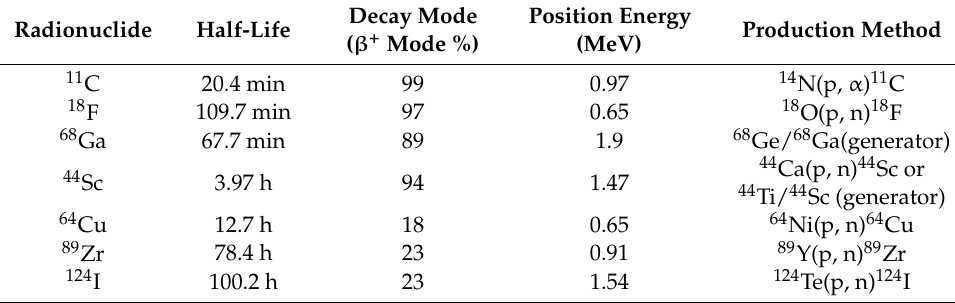
Table 1. Common radionuclides and their physical